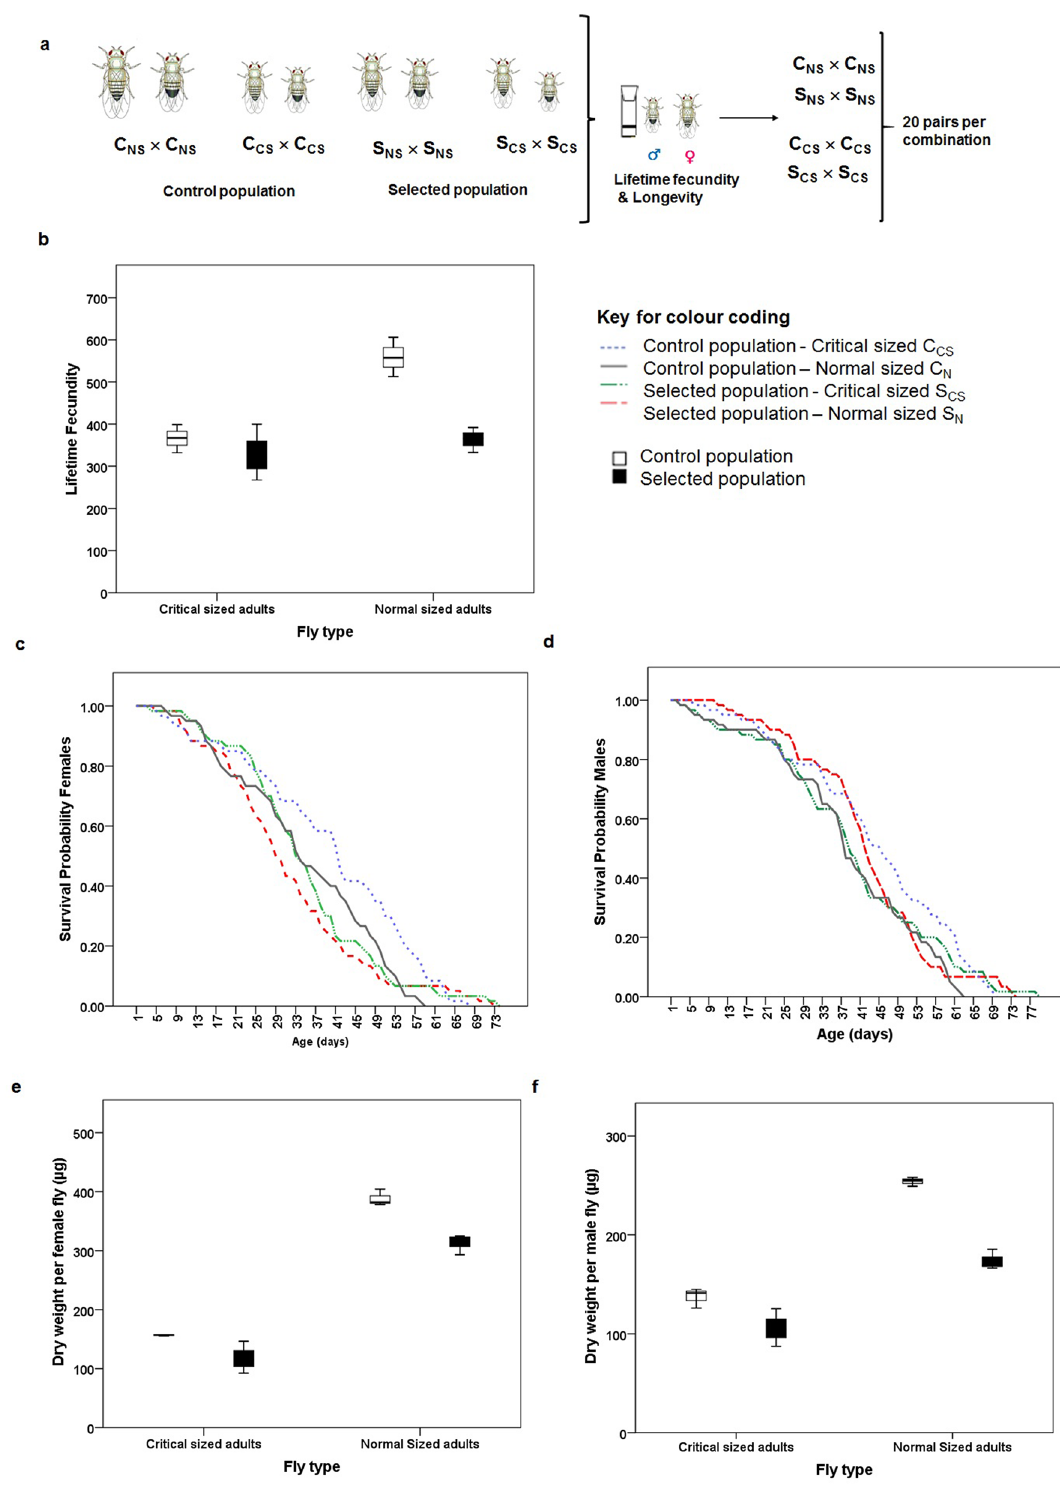
Figure 2. ( a ) Specifications of pairs of flies for longevity and realized life-time fecundity assay set up. ( b ) realized life-time fecundity of selected and control population under critical size and normal size conditions, ( c ) survival probability of females, ( d ) survival probability of males, (e) dry weight (µg) per female fly, and ( f ) dry weight (µg) per male fly. Box plot is depicting the median value along with lower and upper quartile and the whiskers indicate the minimum and maximum